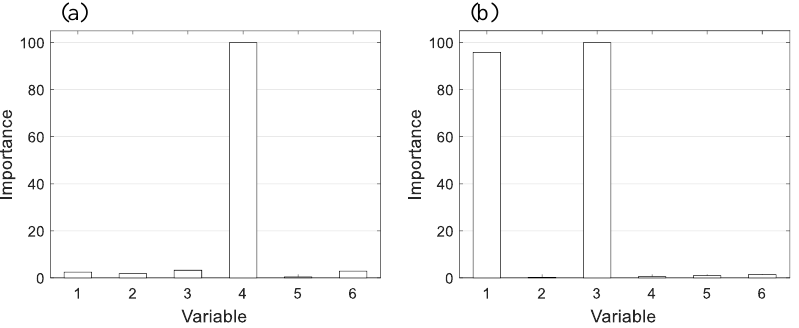
Figure 3. (Simple linear process) Variable importance values calculated by Method 1: ( a ) simple fault ( t fault start = 301 and t fault = 1000); ( b ) multiple fault ( t fault start = 301 and t fault end